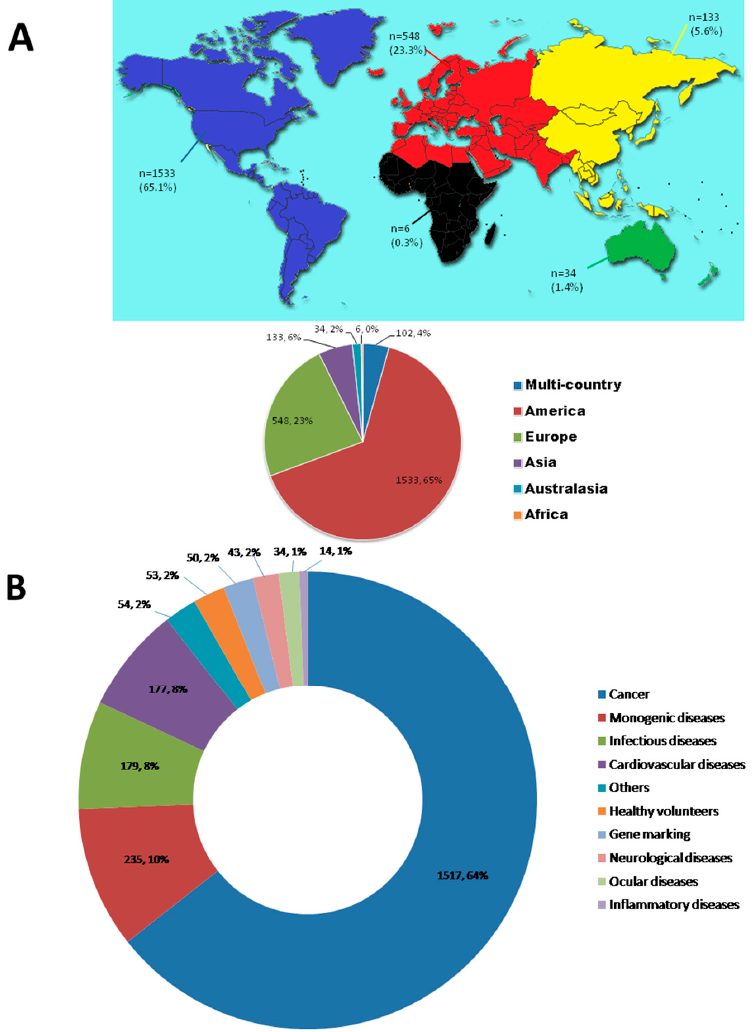
Figure 1. Distribution of Gene Therapy Clinical Trials. ( A ) Geographic distribution of gene therapy clinical trials by continent; ( B ) distribution of gene therapy clinical trials by indication. Data cited from The Journal of Gene Medicine, www.wiley.co.uk/genmed/clinical.